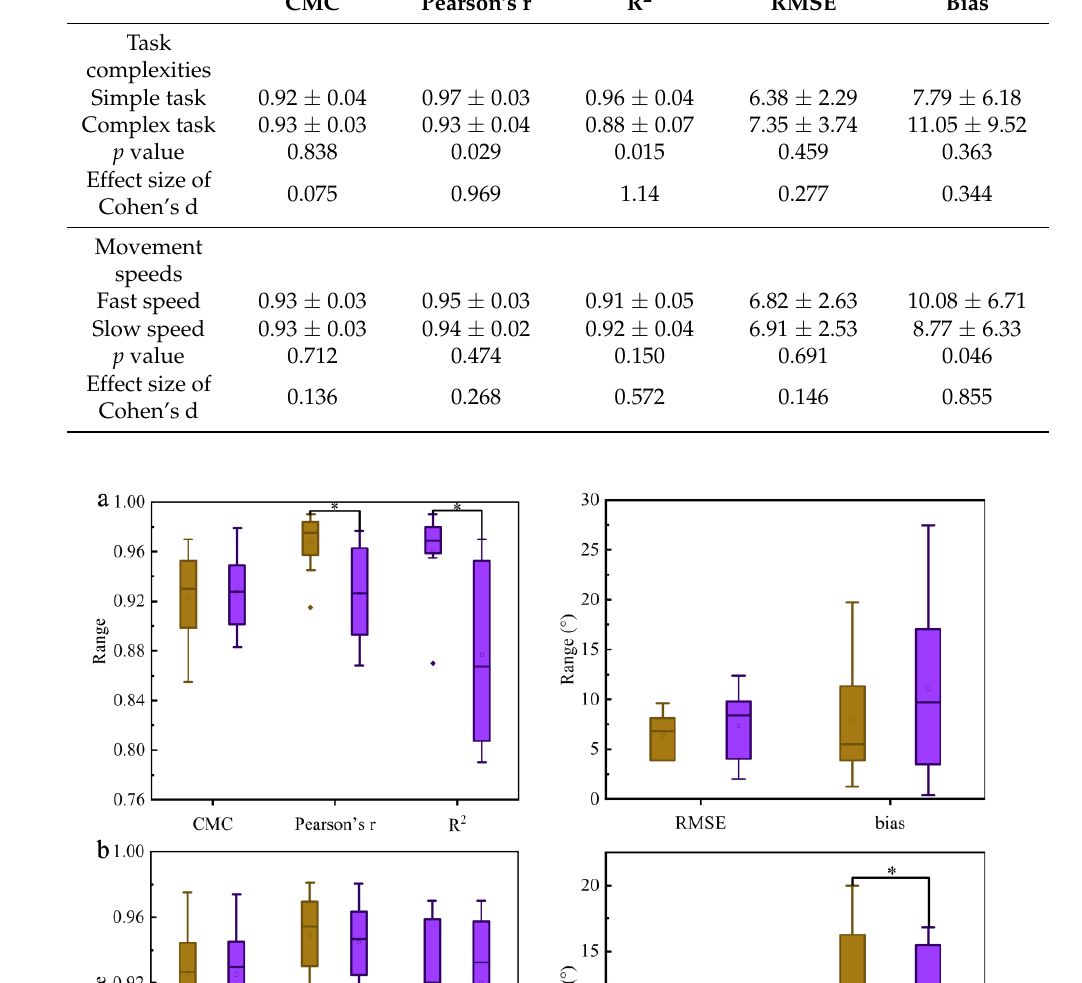
Table 3. Paired t-test for validity metrics between task complexities and between movement speeds.